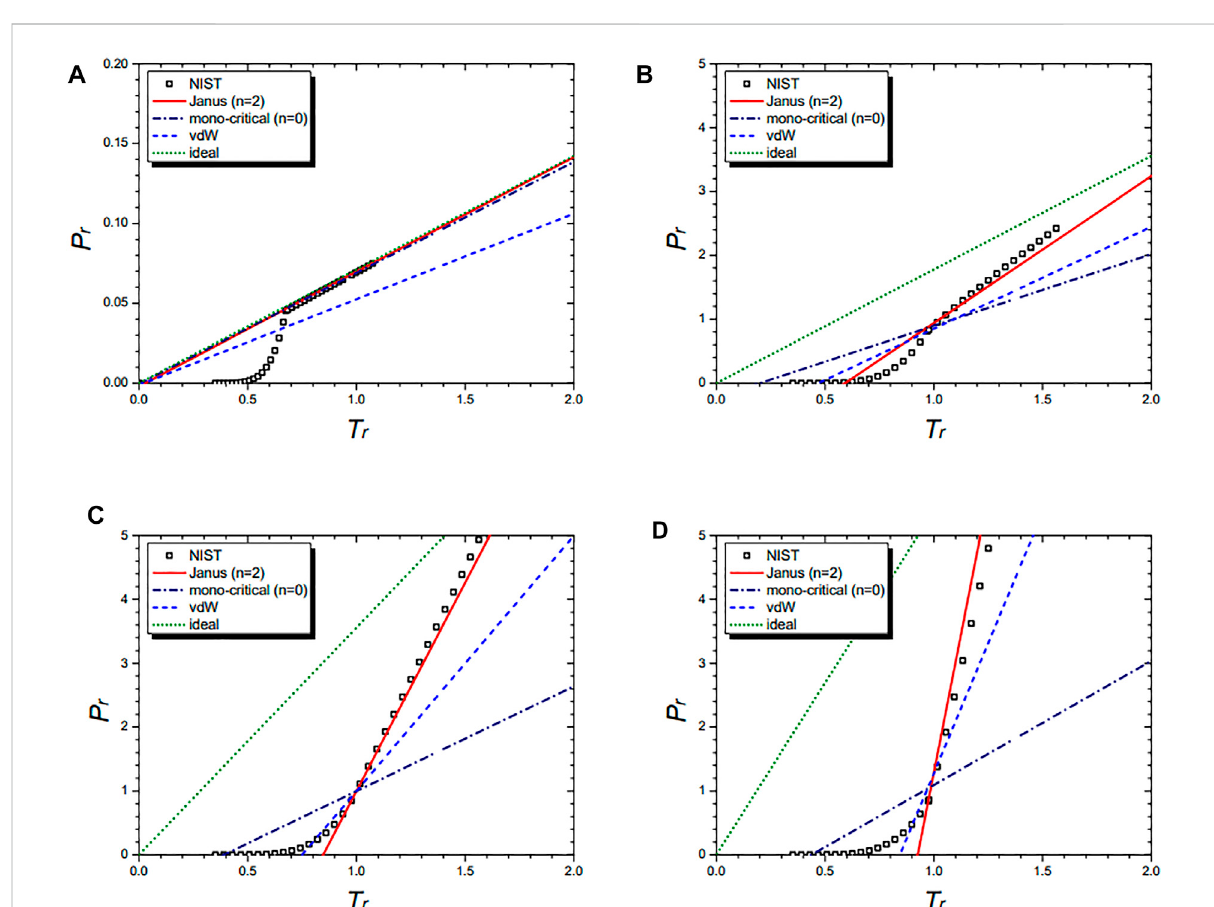
FIGURE 3 Isochoric curves of cyclopentane (C 5 H 10 ) at 1/ v r = 0.02 (A) , 1/ v r = 0.5 (B) , 1/ v r = 1.0 (C) , and 1/ v r = 1.5 (D) ,respectively. Boxes are from the NIST data. The red solid line is drawn from the n = 2 Janus van der Waals Eq. 23 and is better fi tted than the three other equations: the n = 0 mono-critical Eq. 21, the original van der Waals Eq. 1, and the classical ideal gas law (2).